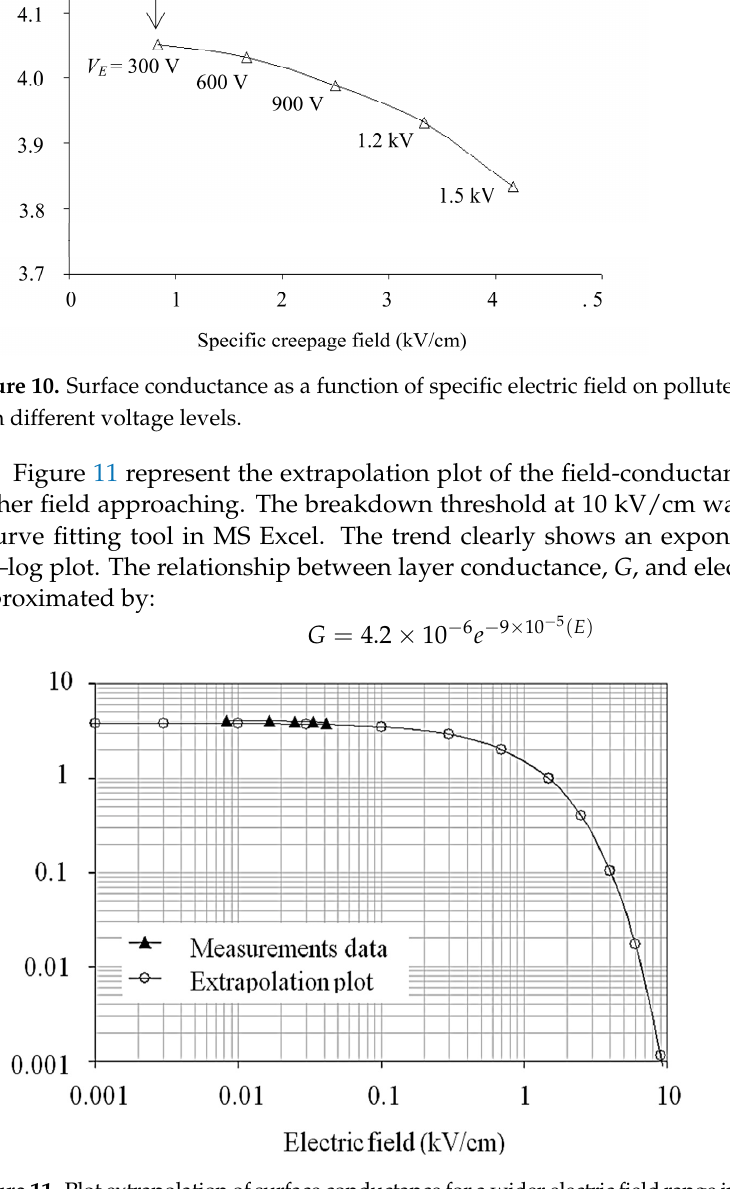
Figure 11. Plot extrapolation of surface conductance for a wider electric field range in a log–log graph scale.